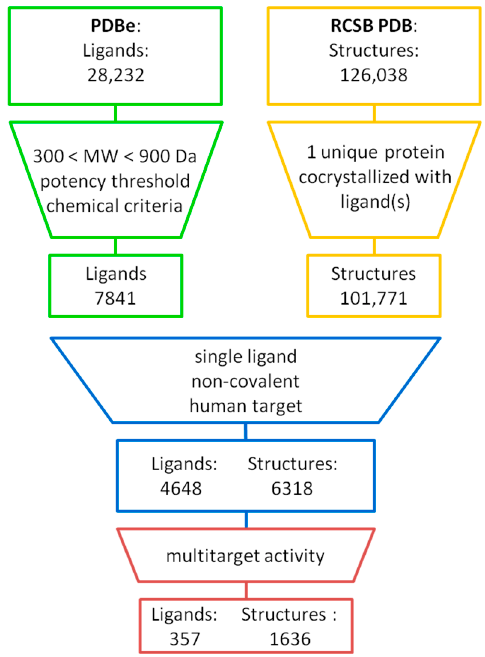
Figure 1. Ligands from X-ray structures. From Protein Data Bank (PDB) entries, unique ligands were extracted and filtered for molecular weight, potency annotations, and (bio-)chemical characteristics (see Materials and Methods for details). Only human proteins complexed with single non-covalent ligands were further considered. Qualifying X-ray ligands in complexes with different targets were identified, yielding 357 MTLs.